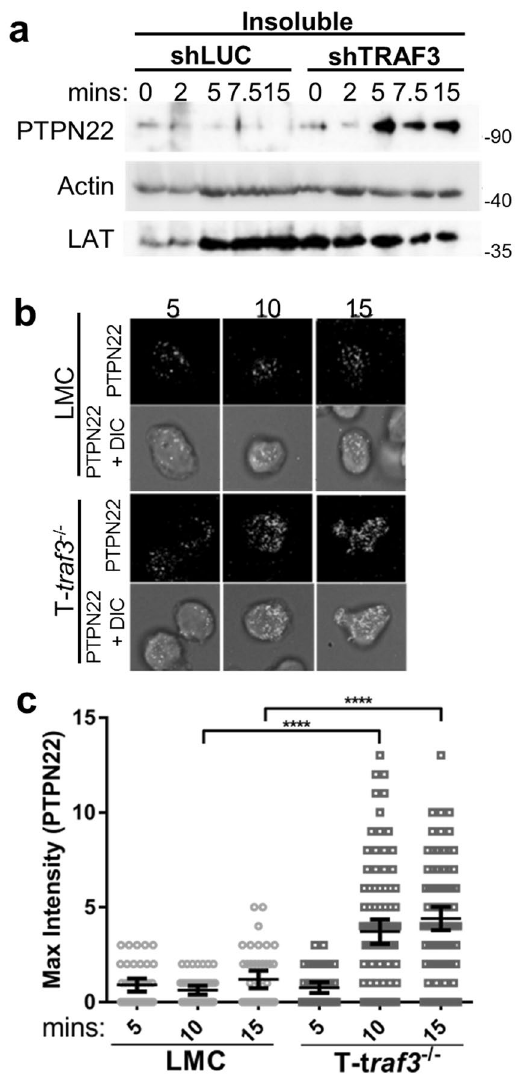
Figure 5. TRAF3 regulation of PTPN22 localization and association with membrane Csk. T cells were stimulated for indicated times via CD3/CD28 ( a and b ). Cellular fractionation was performed on shLUC and shTRAF3 T cells to obtain the insoluble (membrane) fractions. ( a ) Total PTPN22, Lck and actin expression in the insoluble cell fraction was determined by Western analysis using the respective Abs. Western blots were cropped to focus upon the designated proteins. Full-length blots are presented in Suppl. Fig. S5. ( b and c ) Primary mouse splenic T cells isolated from LMC and T- traf3 − / − mice were permeabilized and stained with an anti-PTPN22 Ab followed by a secondary Ab for Alexa-488, then analyzed by Total Internal Reflection Fluorescence (TIRF) microscopy. ( b ) Representative TIRF images and ( c ) quantification of each cell for maximum intensity of PTPN22 fluorescence was determined as in Methods (n = 50 cells per time point). A 1-way ANOVA was performed to establish statistical significance, * P < 0.0001. Data are representative of 3 ( a ) or 2 ( b and c ) independent